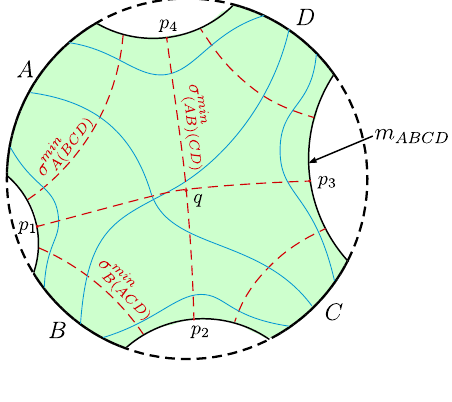
Fig. 4 The max thread configuration for quadripartite case. Threads are unoriented and can intersect with others. The number of threads connecting to each single region reaches its maximum